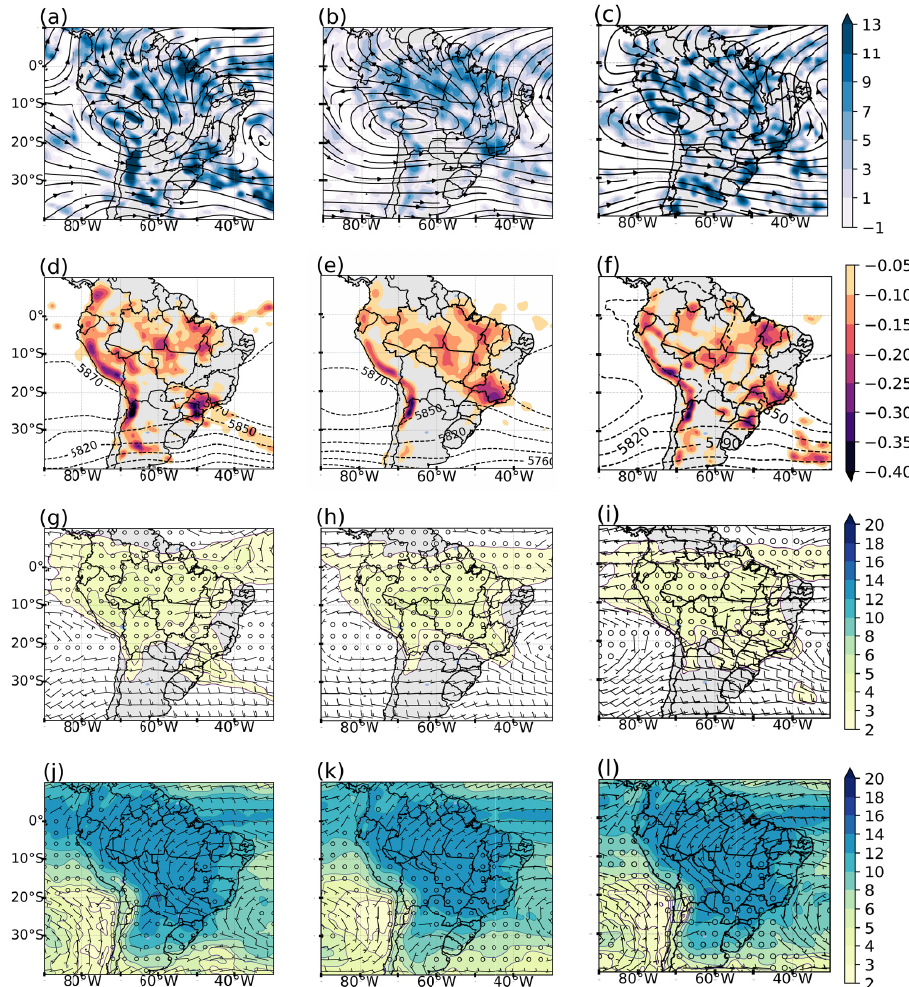
Figure 2. Composites of the streamlines and horizontal divergence of wind (1 × 10 − 5 · s − 1 ) at 250 hPa ( a – c ), geopotential height and omega (Pa · s − 1 ) at 500 hPa ( d – f ), specific humidity (g · kg − 1 ) and winds at 500 hPa ( g – i ), and at 850 hPa ( j – l ) for − 3D (left), 0D (center), and +2D (right) panels of the SACZ events during the active phase of the